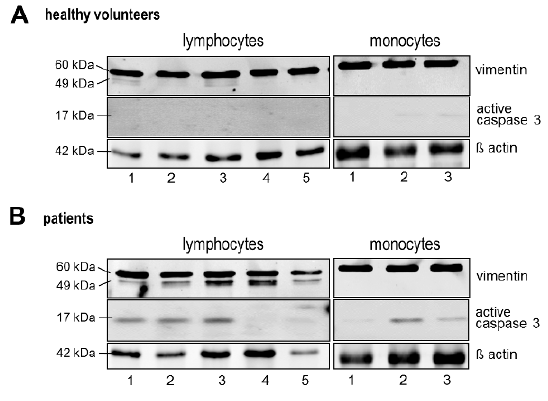
Figure 1. Vimentin expression in lymphocytes and monocytes of patients on hemodialysis. Peripheral blood mononuclear cells (PBMCs) were prepared from healthy donors (A) and patients on hemodialysis (B). Lymphocytes and monocytes were separated and protein extracts were analyzed for vimentin and for active caspase 3 content by Western blotting. Beta actin expression was analyzed for loading control.